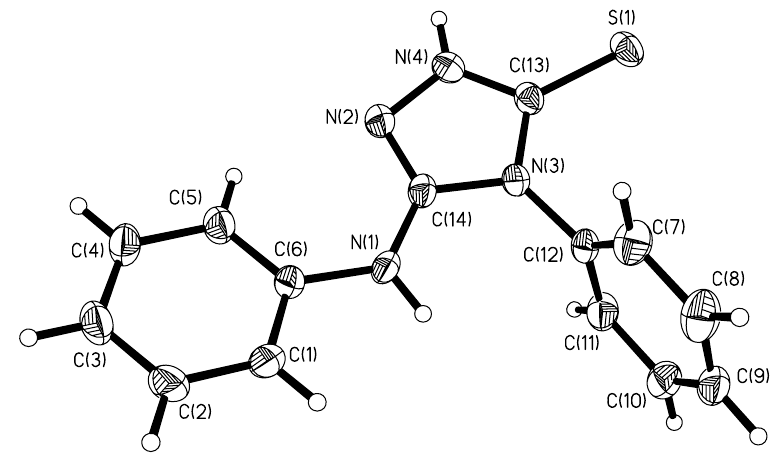
Figure 1 . Molecular structure with the atomic numbering scheme for the title